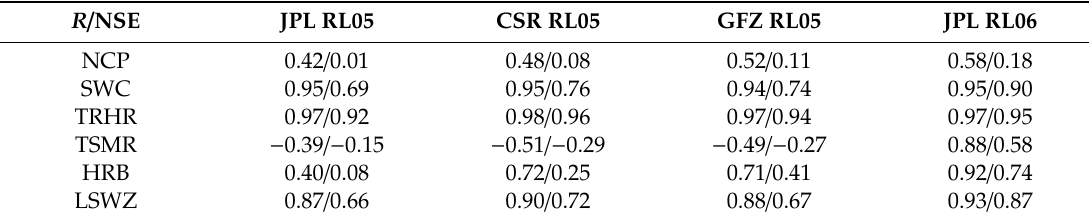
Figure 2. The terrestrial water storage anomaly (TWSA) derived from Gravity Recovery and Climate Experiment (GRACE) in typical regions in China compared with Mascon. Table 2. Accuracy indicators of regional TWSA compared to Mascon results. NSE: Nash–Sutcli ff e e ffi ciency; R : correlation coe ffi